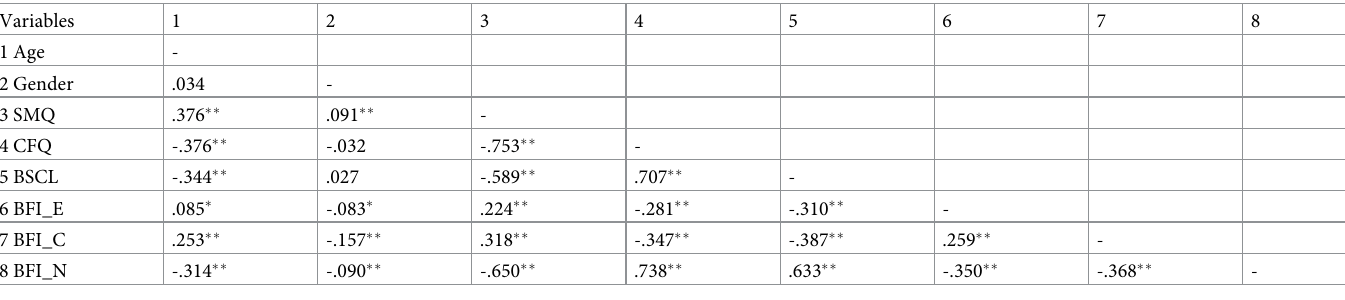
mindfulness and negative affect as well as between the mediator cognitive fusion and negative affect were examined, addressing the first two hypotheses (see Table 3). As predicted, mindful- ness was negatively correlated with negative affect ( r = -.589, p < .001) and cognitive fusion was positively correlated with negative affect ( r = .707, p < .001). Based on the moderate corre- lations between age and the predictors, age was included as a covariate in the analysis. In the first step of examining the proposed moderated mediation model, the SPSS PRO- CESS macro Model 4 (see Fig 1) [54] was used to test the third hypothesis, namely whether